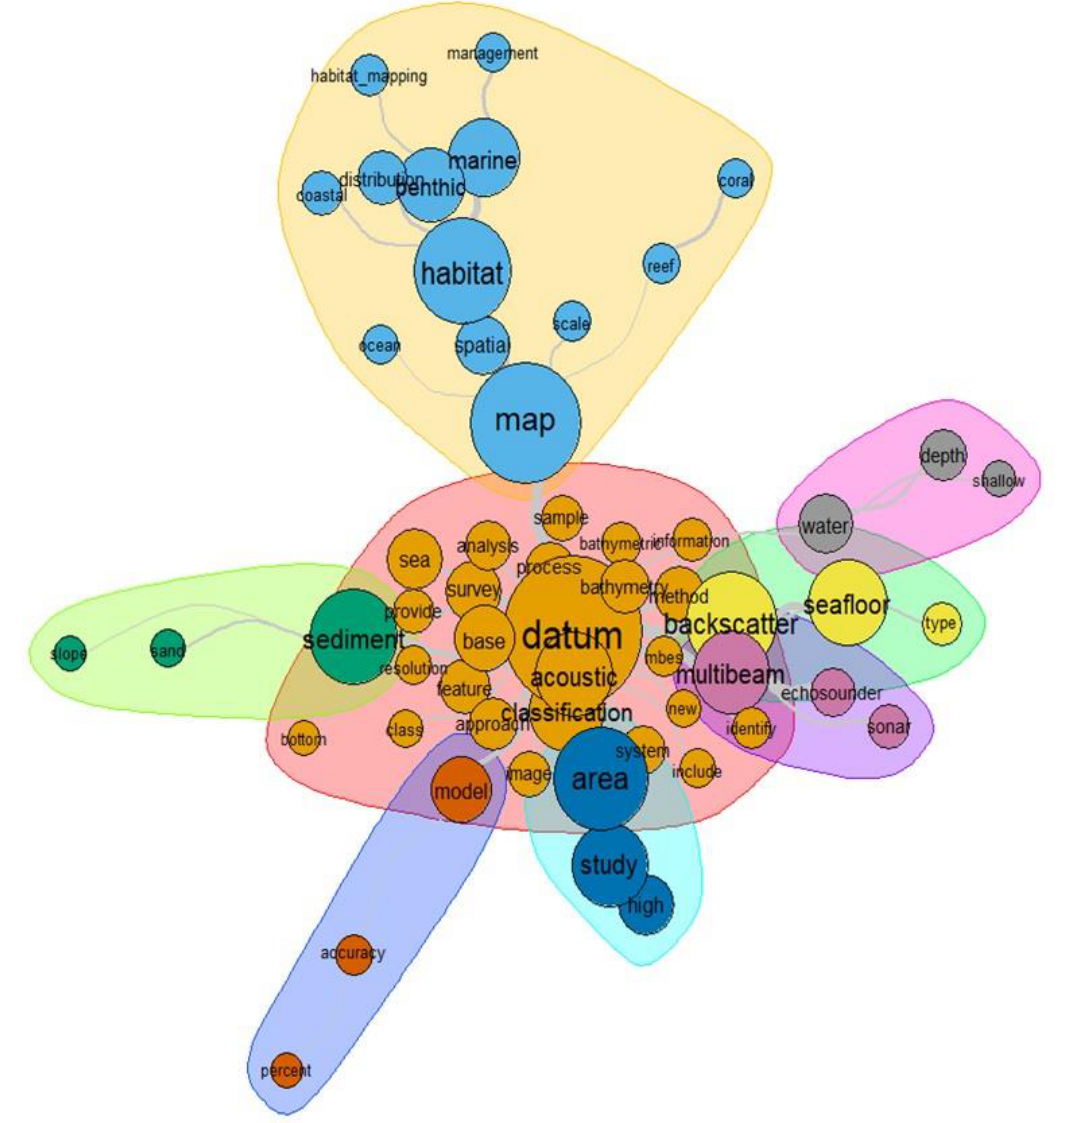
Figure 7. Graph of the similarity among the more frequent terms in the decade of 2011–2019. Note that colors do not represent a specific similarity value. Colors are used to clearly represent the word clustering. The bigger the word font and the associated circle, the higher is the frequency of appearance of that word. The thickness of the grey roots connecting the words represents the frequency that two words appear close to each other, i.e., the co-occurrence among the words. Thicker roots mean higher frequency.